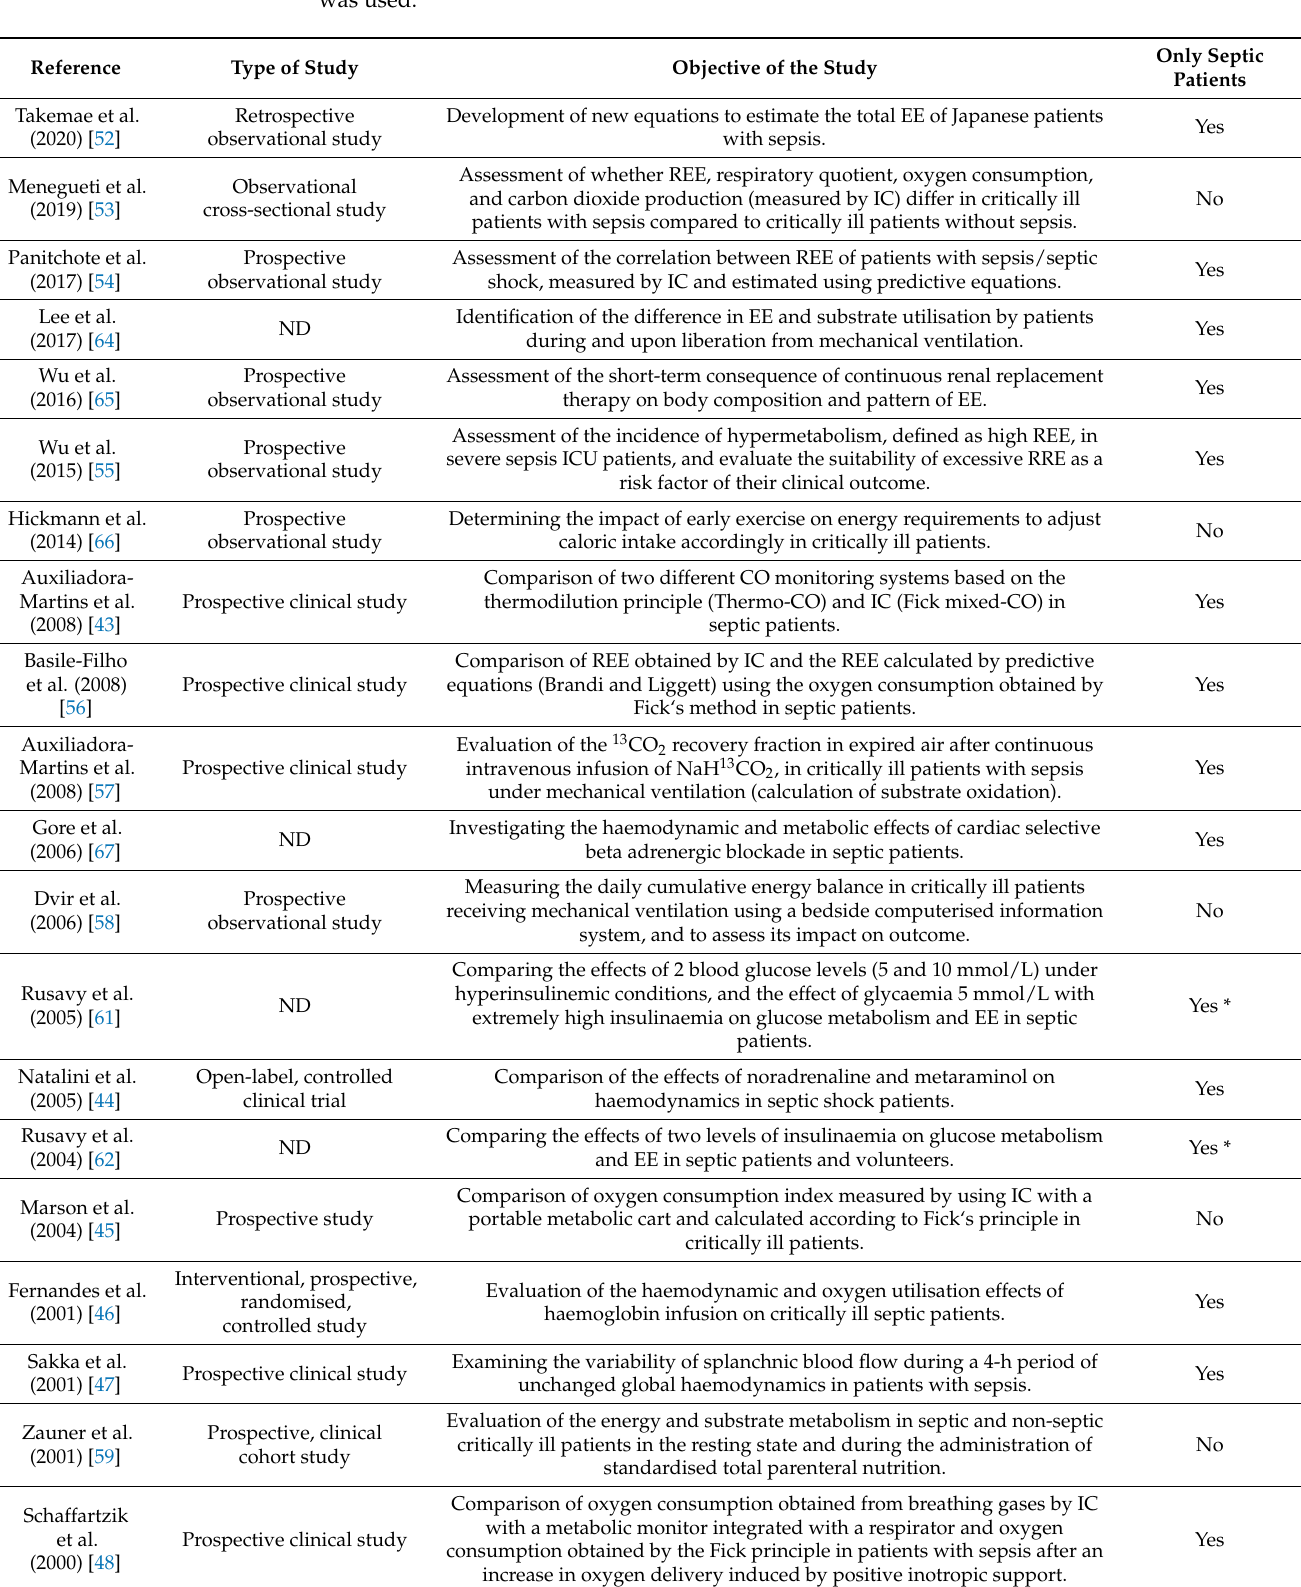
Table 1. Summary of studies in patients with sepsis/septic shock in which indirect calorimetry was